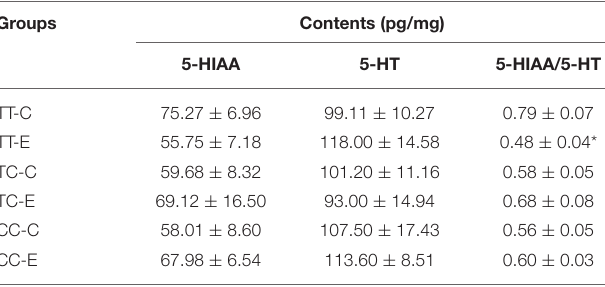
TABLE 1 | 5-HT and 5-HIAA contents in rats’ hippocampi (means ± SEM).